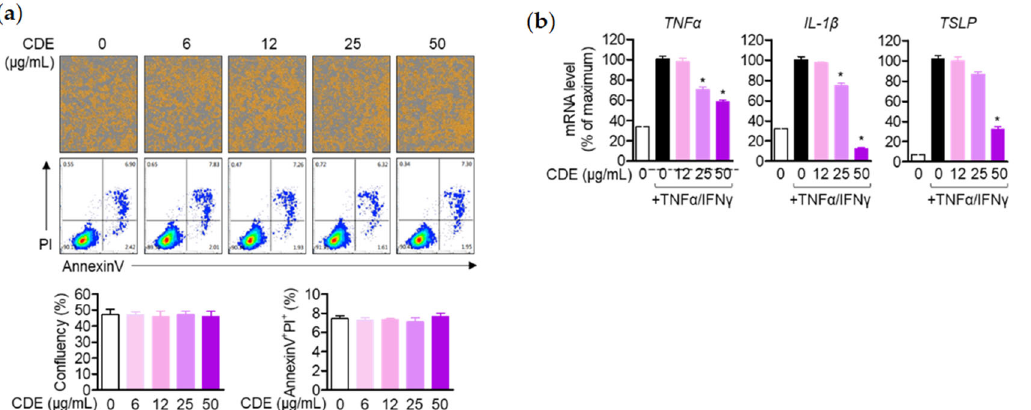
Figure 7. The activity of keratinocytes is regulated by pre-treatment with CDE. ( a ) The indicated concentrations of CDE (0–50 µ g/mL) were incubated with Jurkat cells for 24 h, using a staining reagent for IncuCyte (1X AnnexinV) to detect AnnexinV, and the intensity of AnnexinV was obtained with the IncuCyte imaging system. For the determination of the AnnexinV + PI+ population, an AnnexinV/PI apoptosis assay was performed, using cells cultured according to the manufacturer’s instructions. ( b ) The mRNA levels of inflammatory cytokine genes were assessed by qPCR, and all gene expression was normalized to gapdh expression. Results are expressed as mean ± SEM of three independent experiments (* p < 0.05).